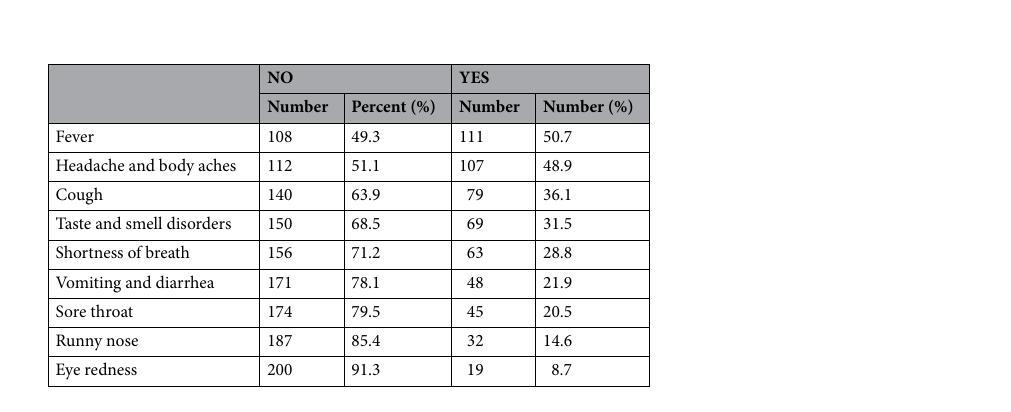
Table 2. Signs and symptoms of the study